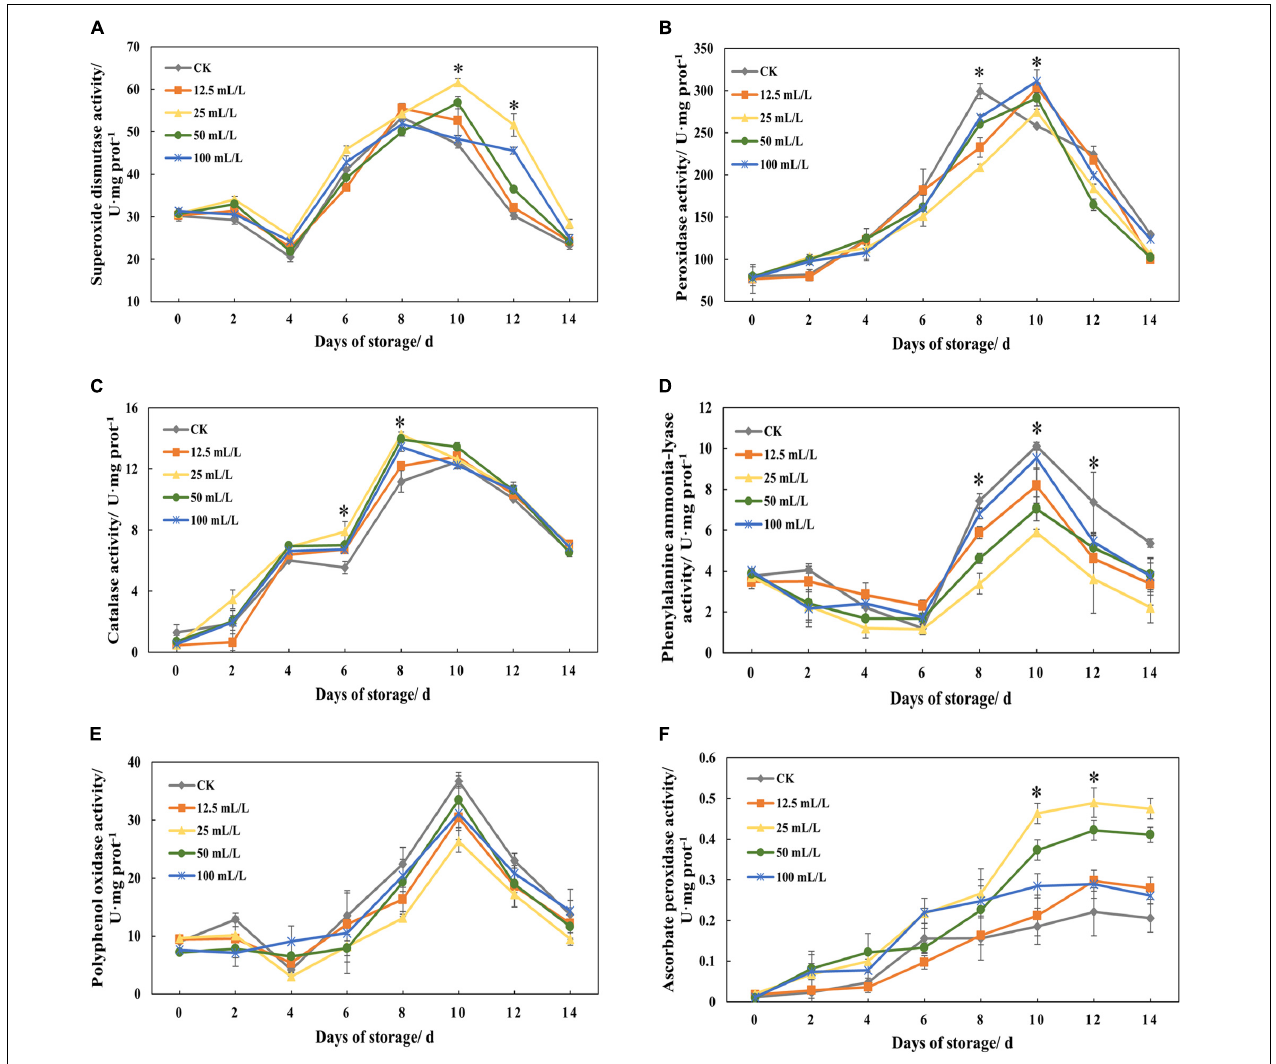
FIGURE 4 | (A) Superoxide dismutase activity, (B) peroxidase activity, (C) catalase activity, (D) phenylalanine ammonia-lyase activity, (E) polyphenol oxidase activity, and (F) ascorbate peroxidase activity of papaya fruits treated with 0, 12.5, 25, 50, and 100 mL/L ethanol. Values are means ± SD. *Represents significant differences among the treatments ( p < 0.05).